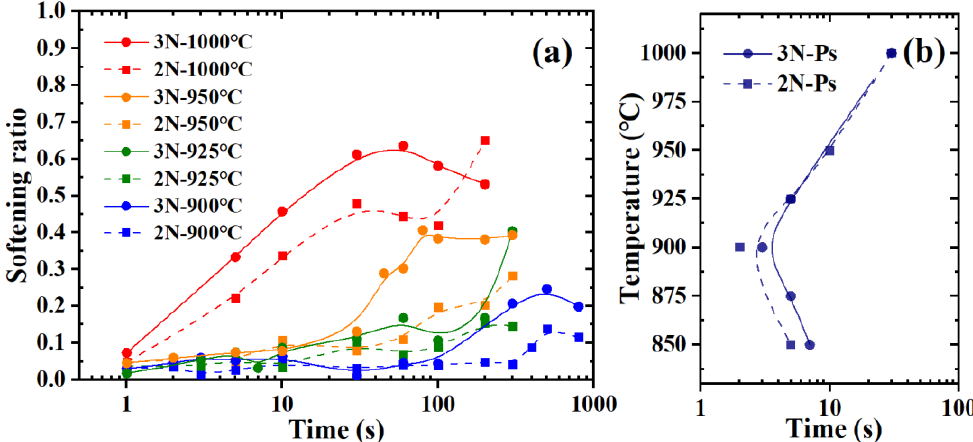
Figure 2. ( a ) Curves of softening ratio X versus the holding time for Steels 2N and 3N at four different holding temperatures. ( b ) Precipitation-time-temperature (PTT) curves of Steels 2N and 3N.